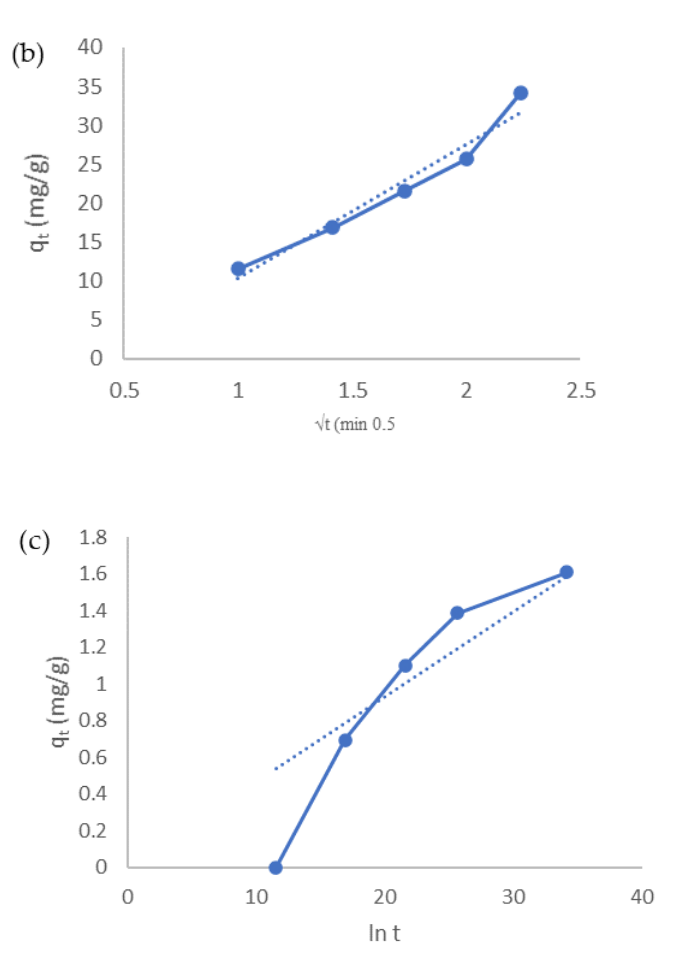
Figure 7. Kinetic plots for the adsorption of CV by LCF: ( a ) pseudo-first-order and pseudo-second- order models; ( b ) intraparticle diffusion model; ( c ) Elovich model. Table 2. Model parameters for adsorption kinetic study of adsorption CV using LCF.